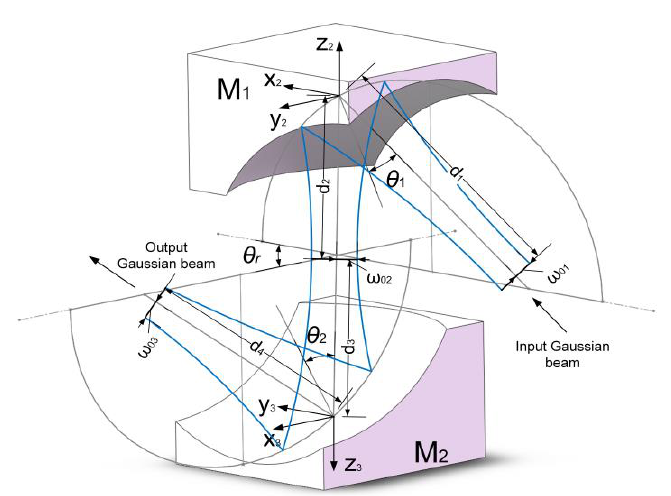
Figure 2. Geometry of a 3-D double ellipsoidal reflector antenna system.